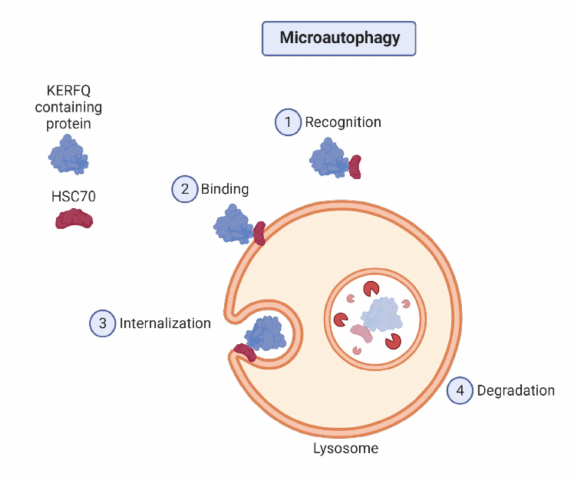
Figure 2. Steps of microautophagy.